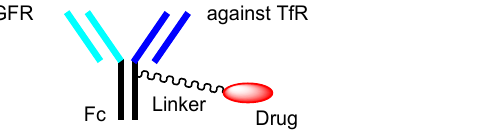
Figure 11. The structure of lysine-MCC-DM1.